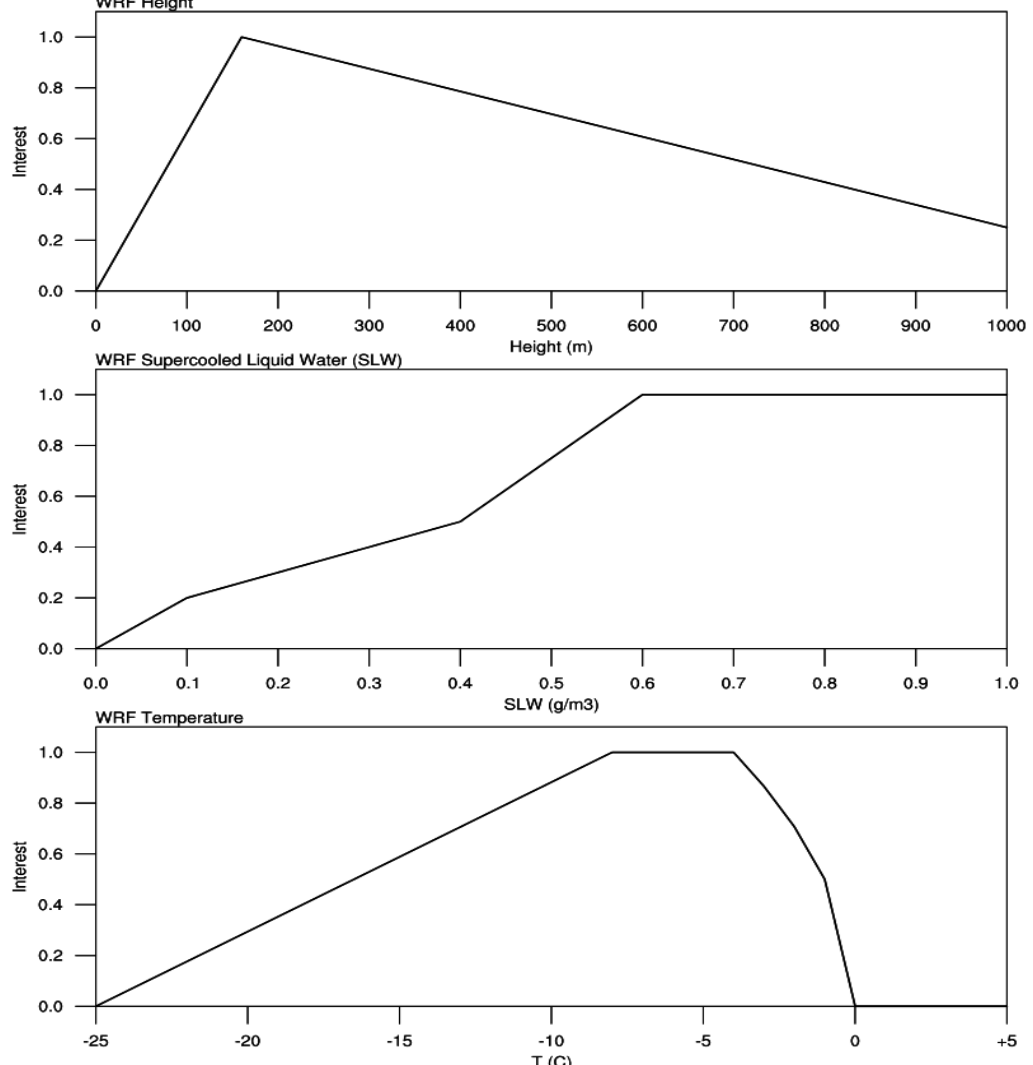
Figure 10. Curves representing the interest in icing conditions (0–1) for three variables from the WRF RTFDDA model data. Top panel is height of the model level, middle panel represents supercooled liquid water, (i.e., liquid rain or cloud drops below freezing), and the bottom panel shows temperature. The intersection of the three curves where they return a value of 1 will maximize the icing potential from the WRF RTFDDA model data. SLW: supercooled liquid water.